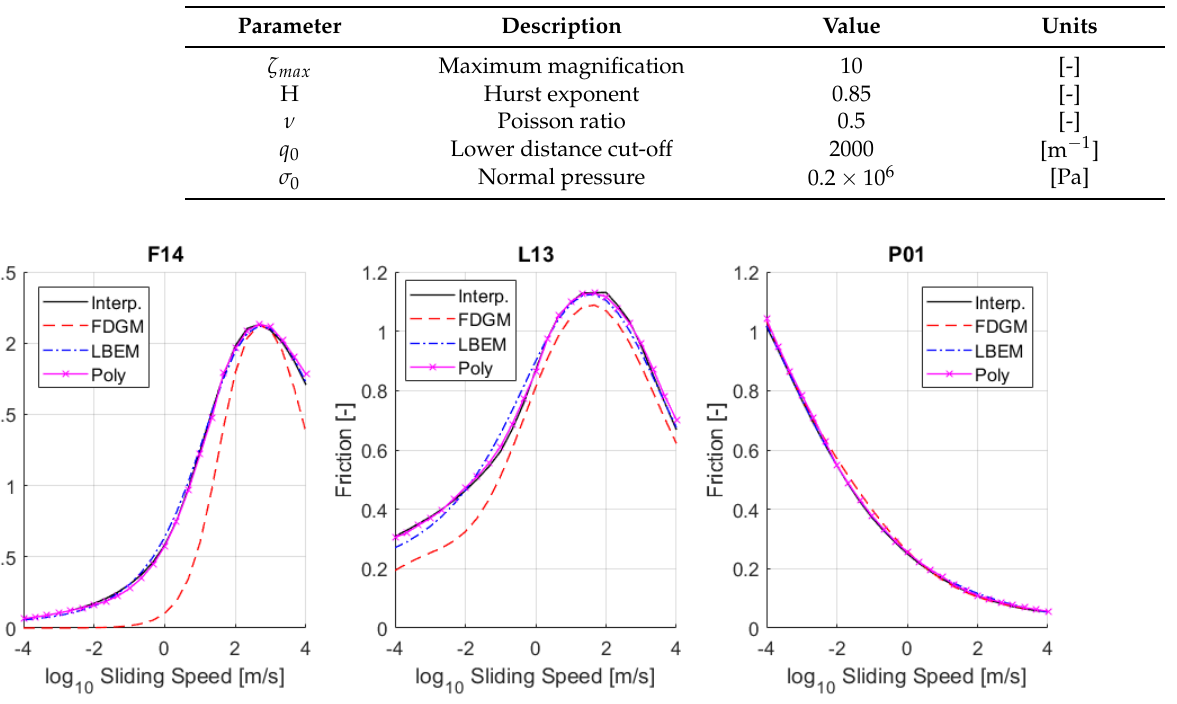
Figure 9. Estimated friction using 4 rheological models for 3 different DMA data